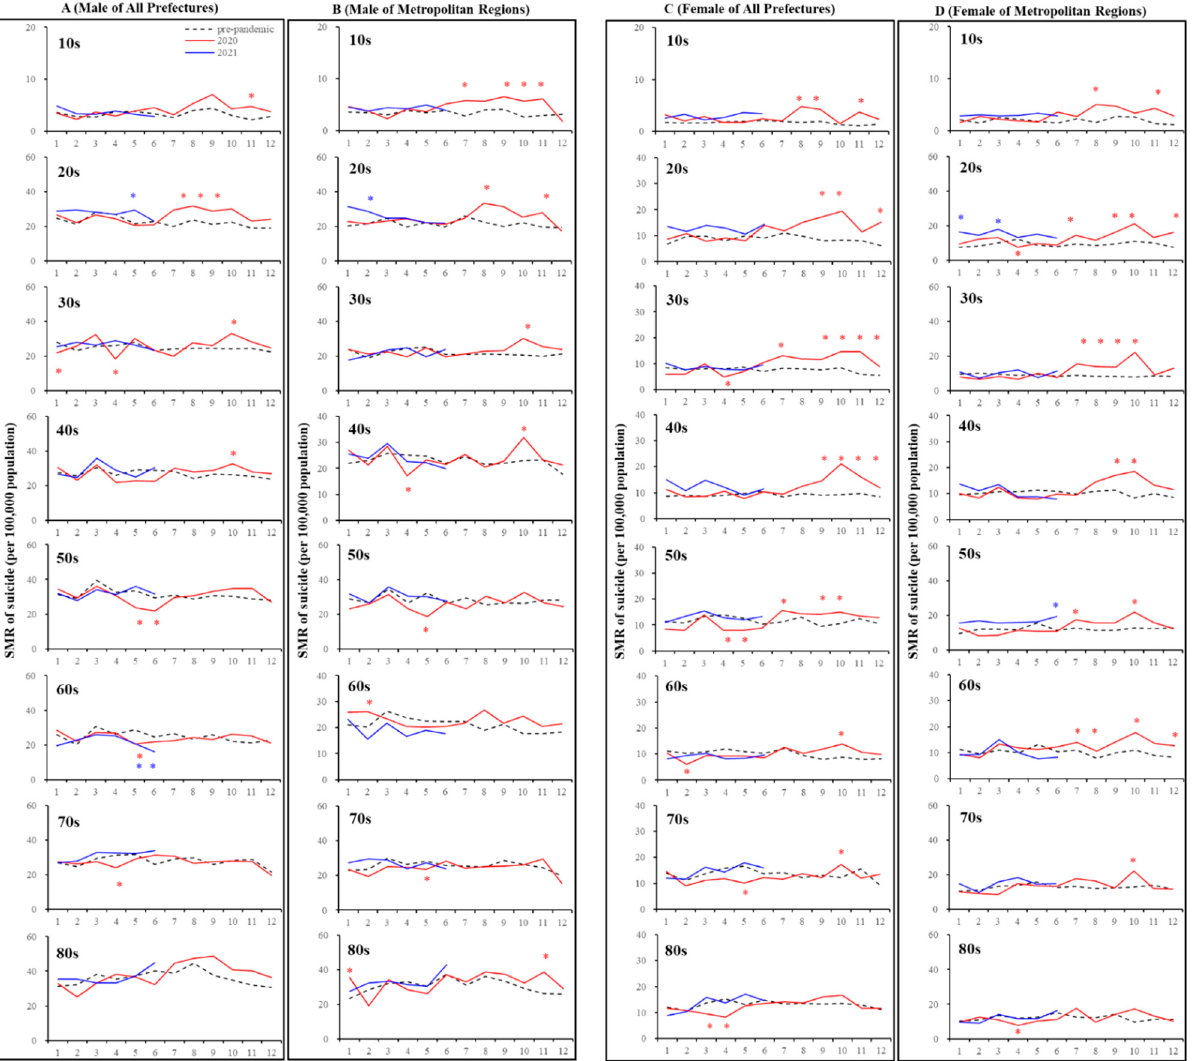
Figure 4. Temporal fluctuations in monthly SMR-S disaggregated by gender, age, and regional factors during the COVID-19 pandemic period (2020–2021) compared to the average of SMR-S during the same month during the pre-pandemic period (2017–2019). Dotted black, red, and blue lines indicate the average of SMR-S for ( A ) males from all 47 prefectures, ( B ) males from metropolitan regions, ( C ) females from all 47 prefectures, and ( D ) females from metropolitan regions. Ordinates indicate the SMR-S (per 100,000 people), and abscissas indicate the month. * p < 0.05, significant change using a linear mixed-effects model with Tukey’s multiple comparison. Red and blue asterisks indicate significant changes in SMR-S in 2020 and 2021, respectively, compared to the average SMR-S of the same month during the pre-pandemic